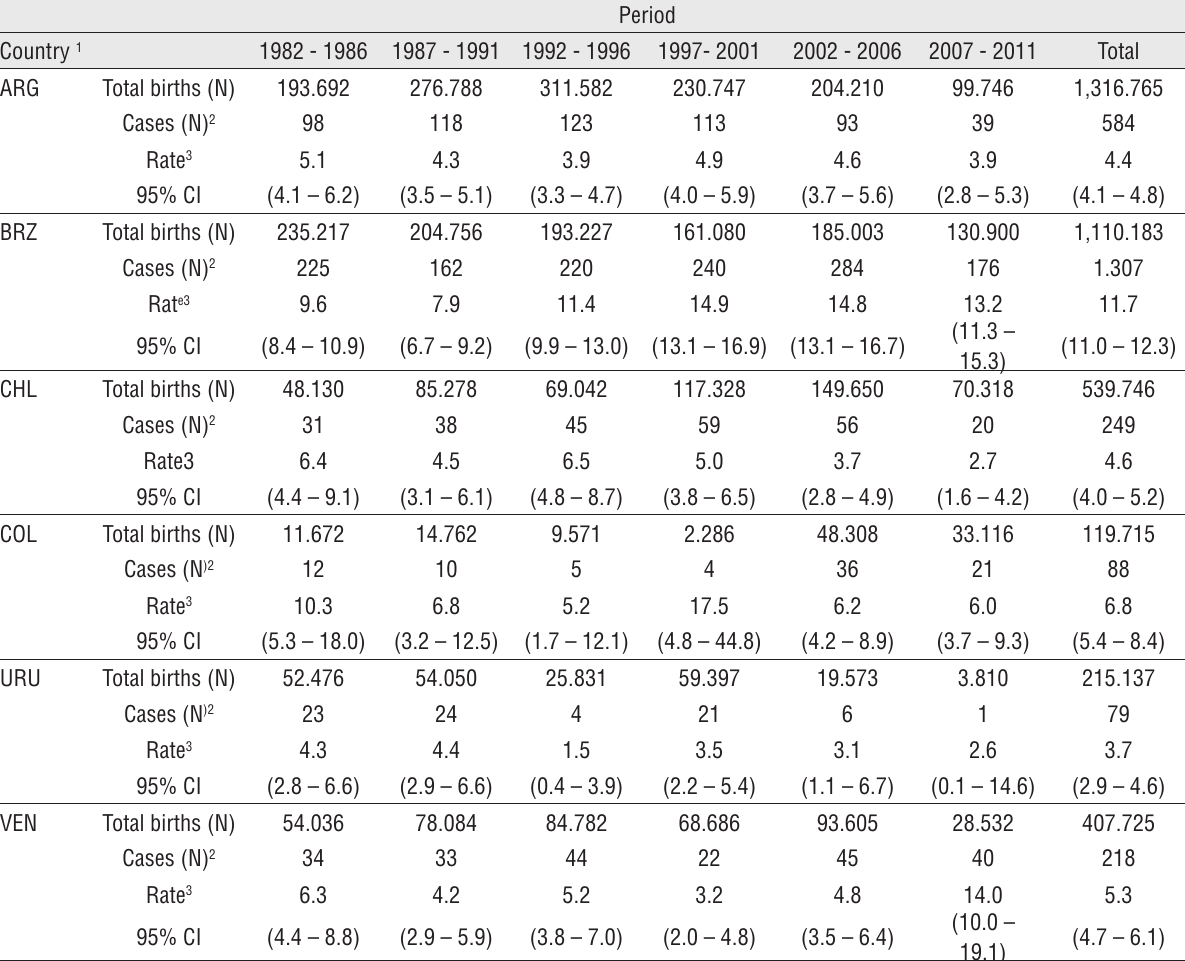
Table 4 - Number of total births, cases and rates (per 10,000 births) of severe hypospadias by period of time in six countries of South